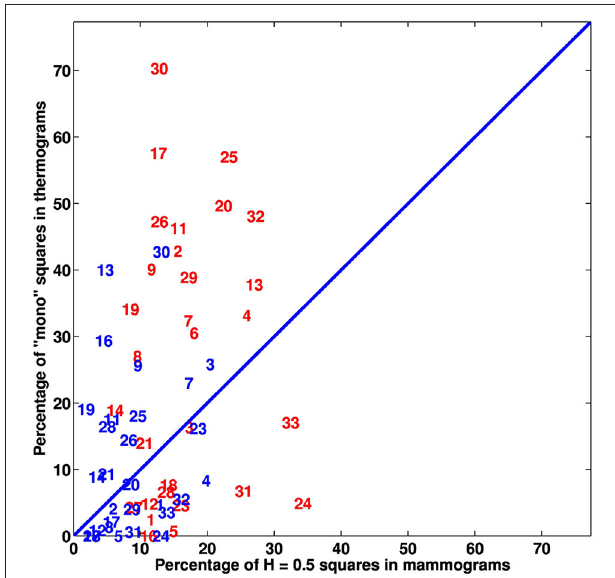
FIGURE 6 | Comparative analysis of thermograms and (CC and MLO averaged) mammograms. Percentage of monofractal squares in thermograms vs. percentage of H = 0.5 squares in mammograms of the cancerous (red) and contralateral unaffected (blue) breasts of the 30 patients with breast cancer. The numbers correspond to patient numbers defined in Table S1.